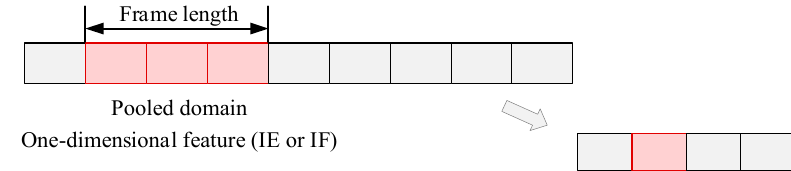
Figure 9. Dimensionality reduction algorithm structure diagram.